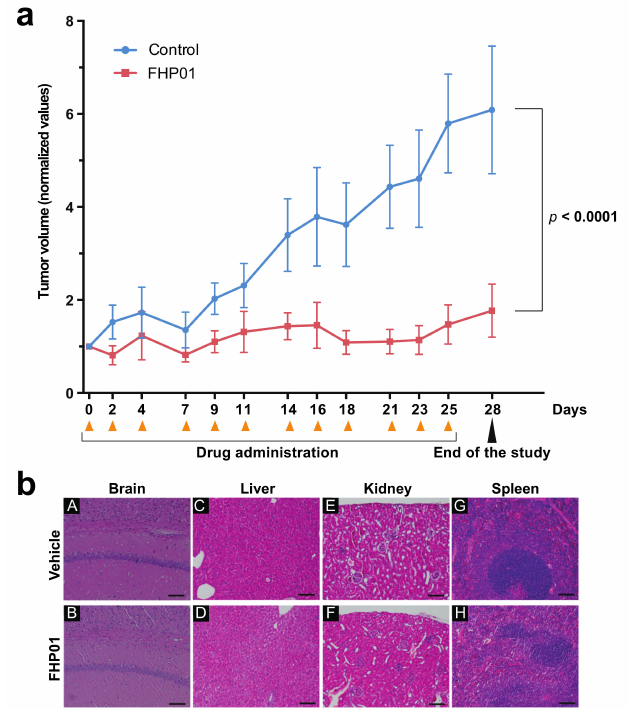
Figure 4. Growth of MDA MB 231 tumor xenografts in nude mice is suppressed in response to FHP01 treatment. ( a ) Athymic nude mice were injected with MDA MB 231 on both flanks. Once tumor volume reached approximately a mean size of 25.42 ± 2.02 mm 3 , animals were treated with 45 mg/kg FHP01 suspension i.p. three times per week for 4 weeks. Average tumor volume of control (blue, n = 8) significantly diverges from the volumes recorded in FHP01 treated (red, n = 9) nude mice. The data of the volumes are normalized to the baseline value of each sample (normalized values) and expressed as mean ± SEM. Comparisons were subjected to two-way RM ANOVA. ( b ) Representative images of organ histological investigation after 4 weeks, three time per week, of i.p. treatment with FHP01 (45 mg/kg). Qualitative analysis did not detect any evident signs of toxicity in brain (A,B), liver (C,D), kidney (E,F), and spleen (G,H) of controls (A,C,E,G) and treated (B,D,F,H) animals (scale bars are equal to 100 µ